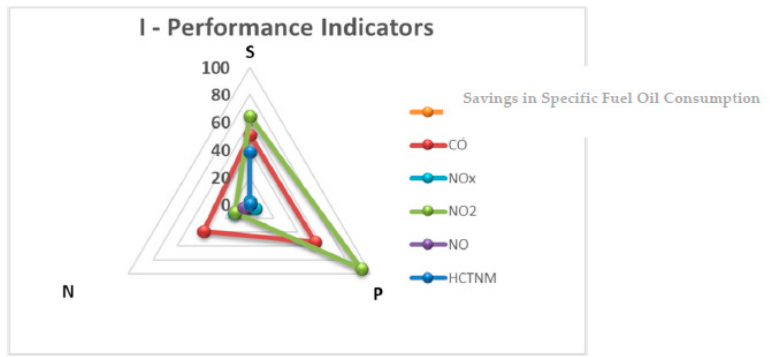
Figure 27. Indicators in process model I .